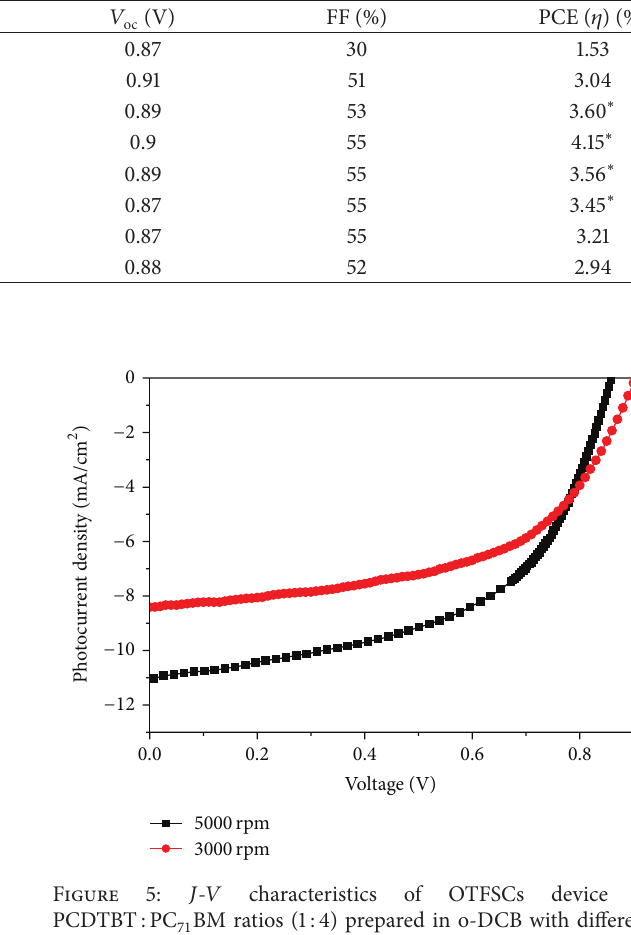
Figure 4: 𝐽 - 𝑉 characteristics of OTFSCs of PCDTBT: PC 71 BM prepared with different mixing ratios 1: 1 ∼ 1:8 in o-DCB.